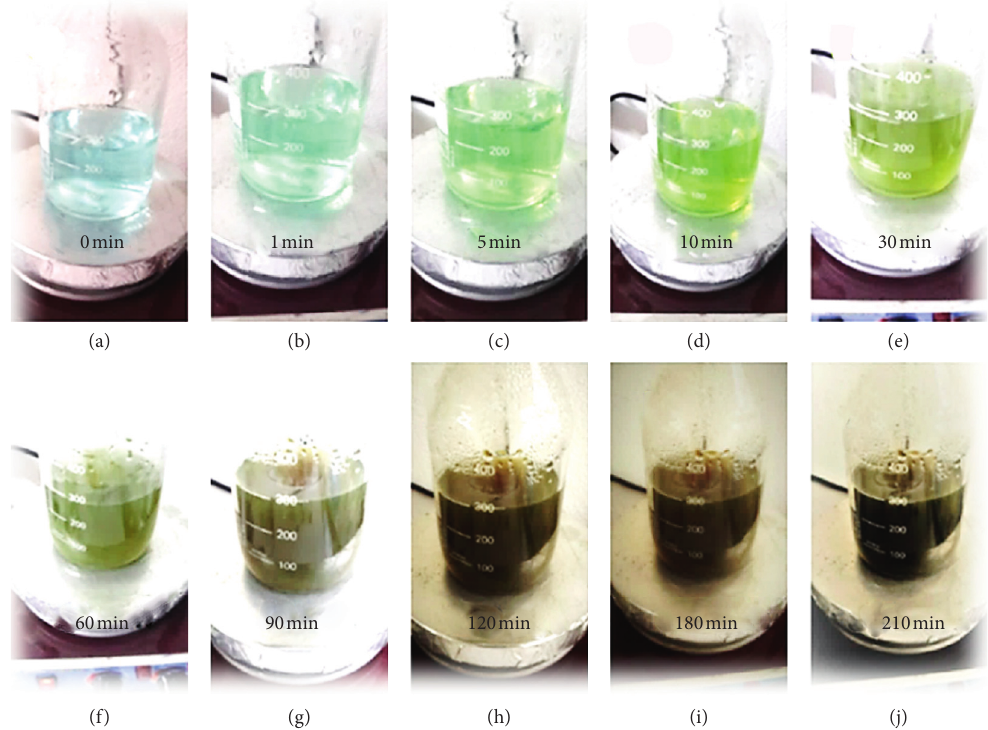
Figure 3: The color change of the biosynthesized CuNPs using pistachio hull extract in varying time